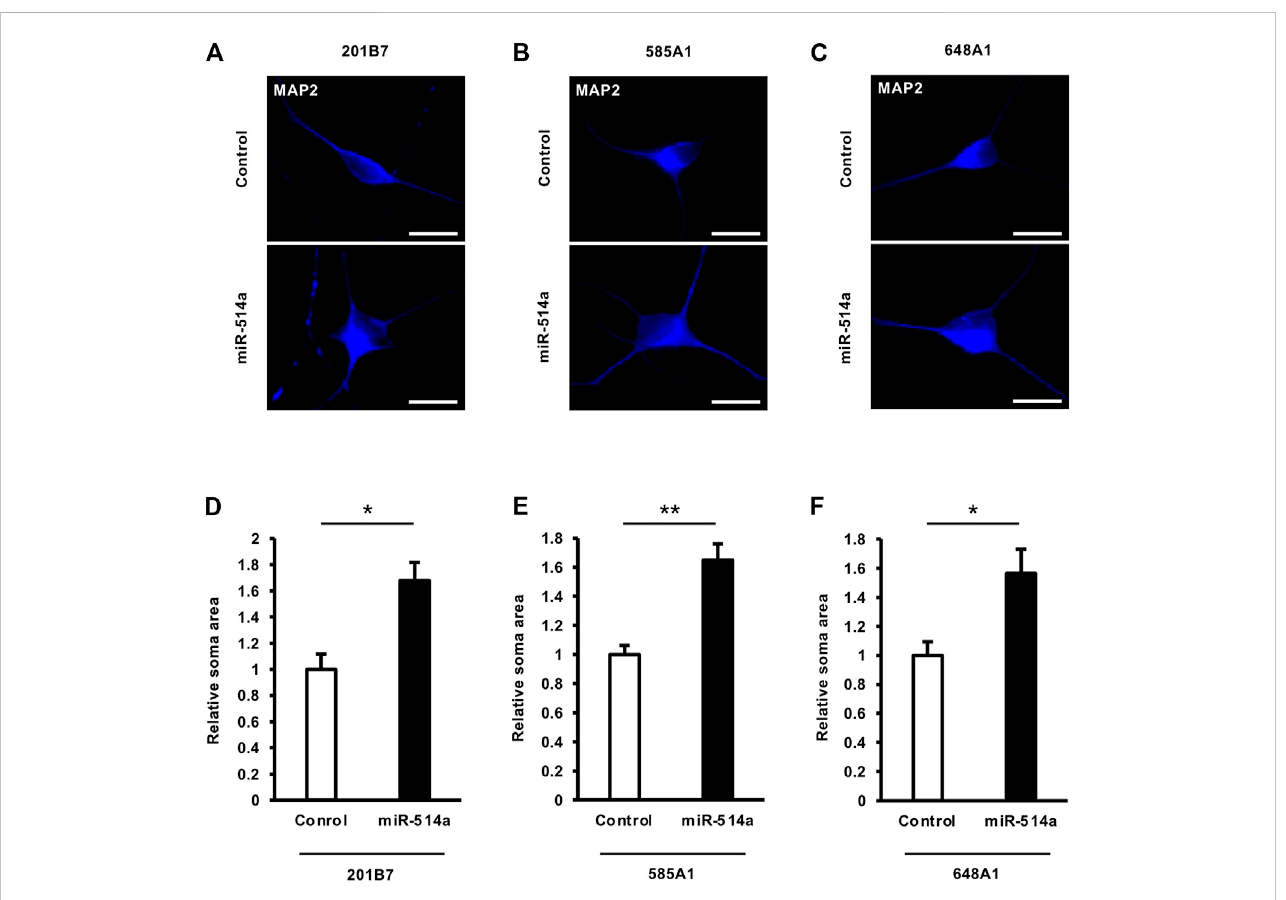
FIGURE 3 miR-514a increases neuronal soma size. Neurons were infected with lentiviruses expressing miR-514a and cultured for 7 days. (A – C) Representative images of iPSC-derived neurons stained with anti-MAP2 (blue) antibody at 7 DIV. Scale bars, 25 µm. (D – F) Quantitative analysis of neuronal soma size of neuronsderivedfromthreeindependentiPSCline,respectively. n =3independentexperiments,atleast100neuronswereanalyzedineachexperiment.** p < 0.01, * p < 0.05. Abbreviations: MAP2, microtubule-associated protein